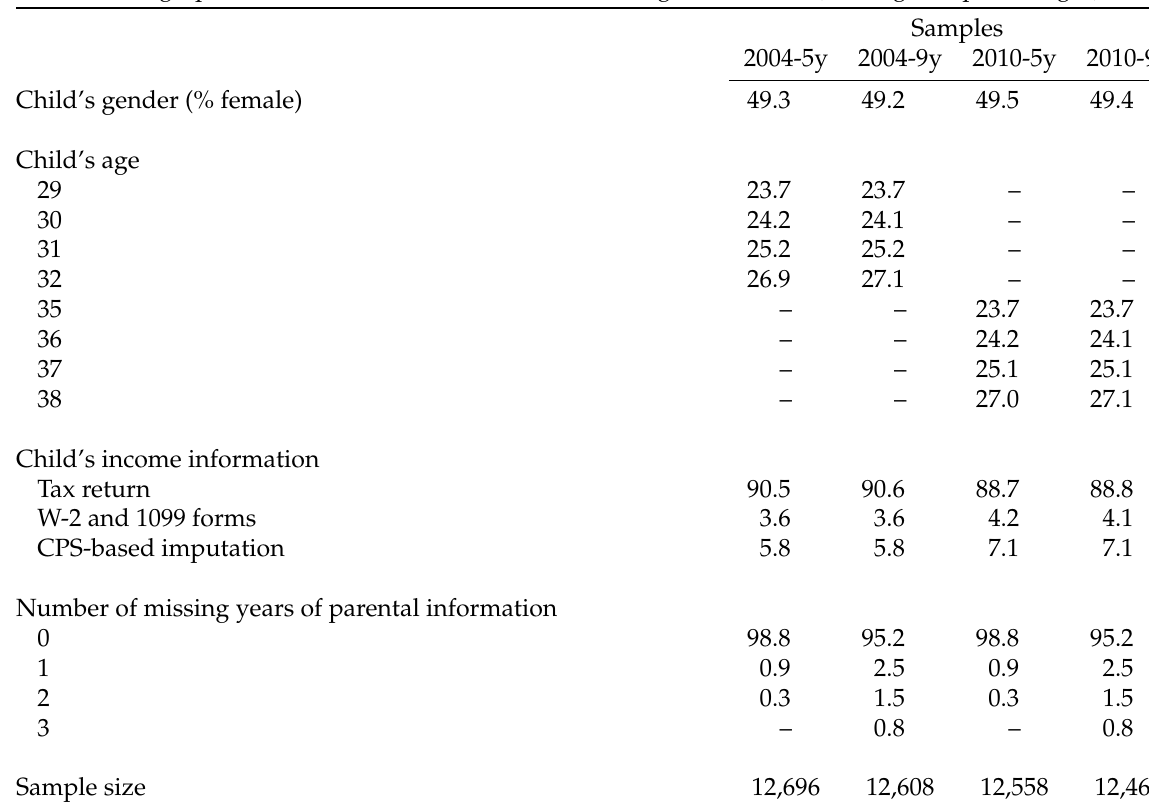
Table 1: Demographic statistics, income sources, and missing information (unweighted